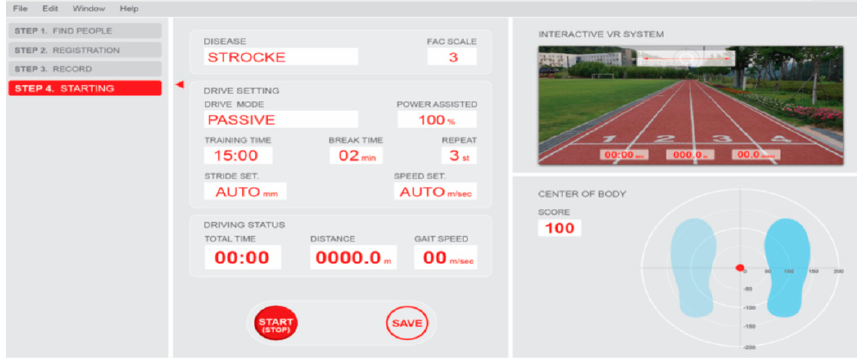
Figure 6. MGTR training program.